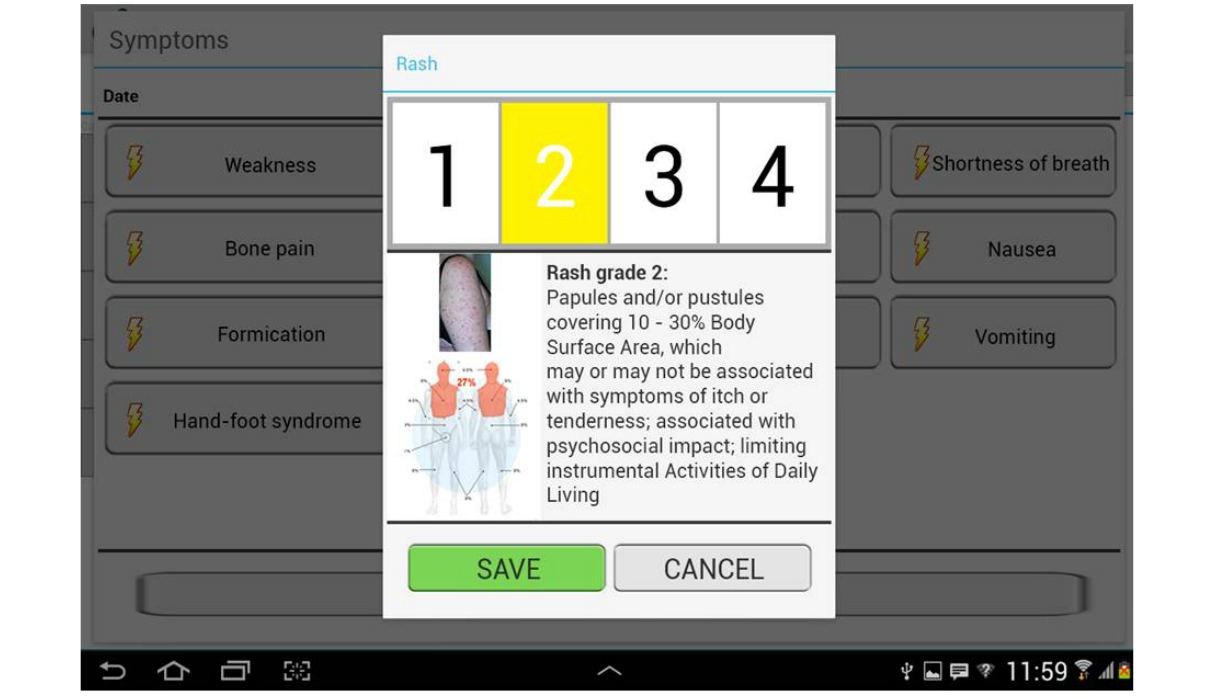
Figure 4. Screenshot of mobile oncological diary showing the window that allows patients to input onset and intensity of therapy-related rash. The app helps patients determine grade of toxicity by displaying explanatory texts and pictures.